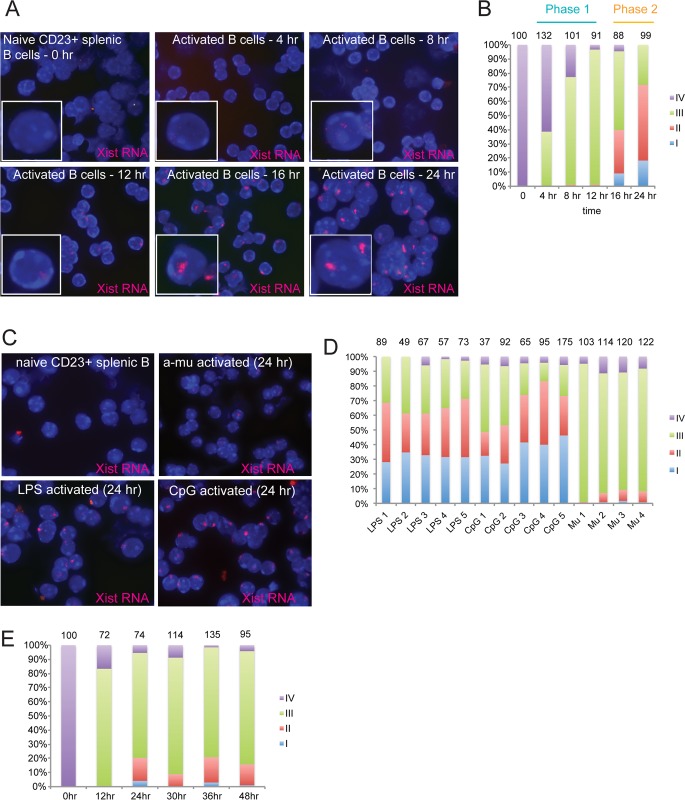
Timing of Xist RNA localization to the Xi during B cell stimulation.(A) Time course analysis, using RNA FISH, to monitor Xist RNA (red) localization changes immediately following B cell stimulation using CpG. Representative field images from one experiment are shown; similar results were obtained across 4 independent replicate experiments. (B) Representative results from one experiment quantifying the Xist RNA localization patterns for each time point after B cell stimulation using CpG. The total number of nuclei counted is shown above each column. Results from independent replicate experiments are shown in S6A Fig, along with statistical significance testing across all three experiments. (C) Representative Xist RNA FISH images of naïve splenic B cells and in vitro stimulated B cells (for 24 hrs) using three different stimuli. (D) Quantification of Xist RNA localization patterns for splenic B cells stimulated for 24 hrs using LPS, CpG, or anti-mu (Mu). Each column shows the average localization patterns for splenocytes from one female mouse. The total number of nuclei counted is shown above each column. (E) Time course analysis of splenic B cells stimulated with anti-mu. Representative results from one experiment quantifying Xist RNA localization patterns. The total number of nuclei counted is shown above each column.